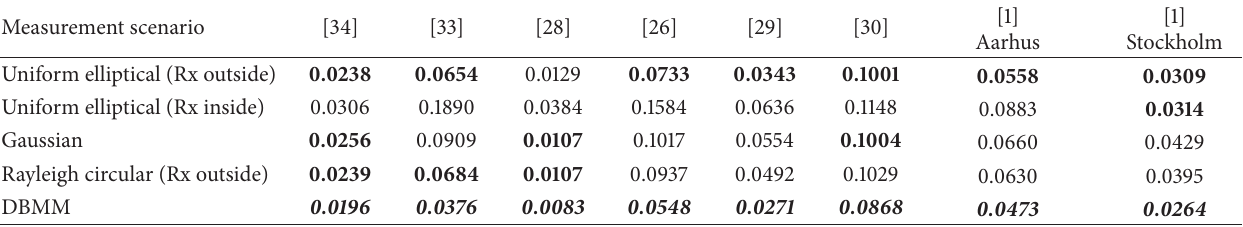
Table 6: Kolmogorov-Smirnov statistic for selected models calibrated by empirical data.